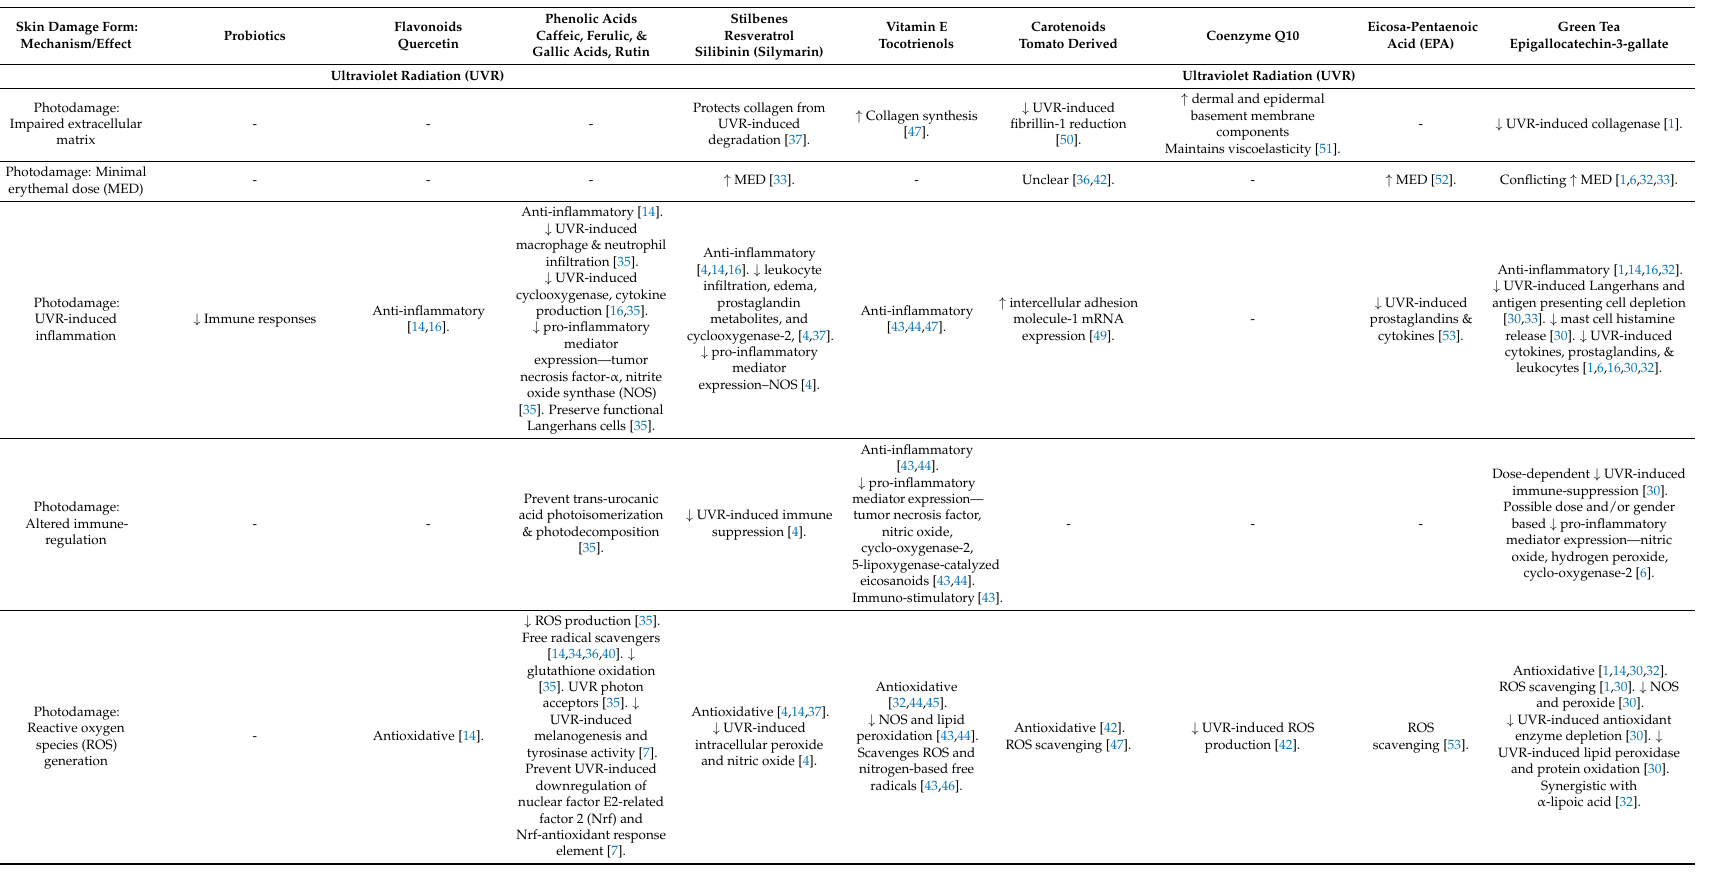
Table 2. Skin protective nutraceuticals’ mechanisms of